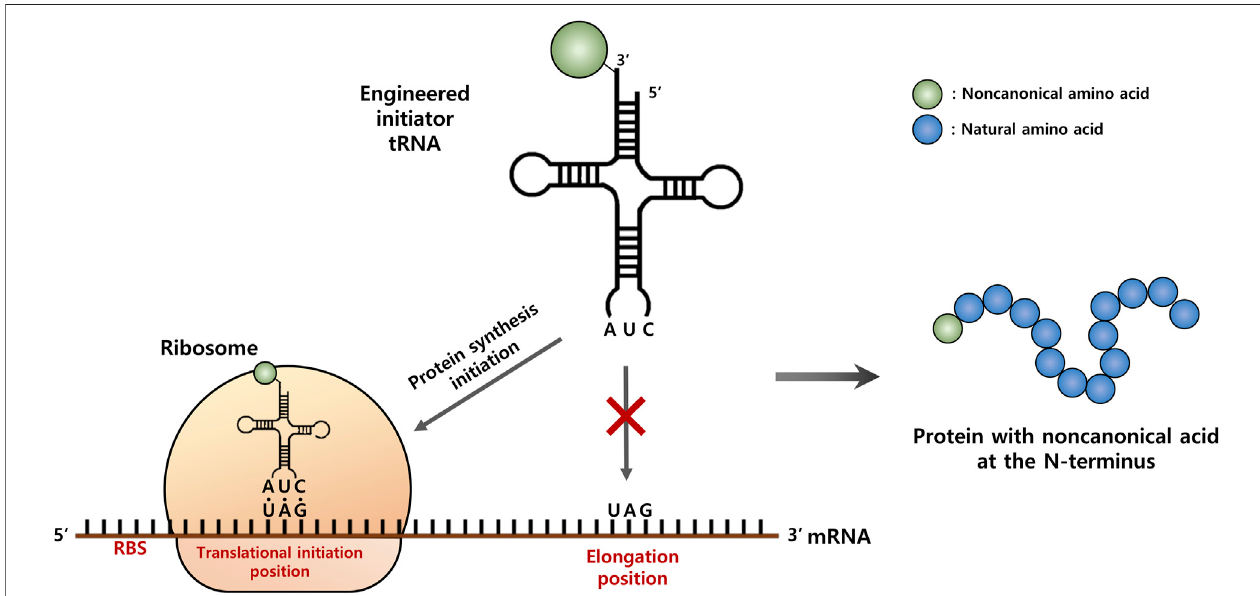
FIGURE 1 | Schematic representation of the strategy for site-speci fi c incorporation of a non-canonical amino acid (ncAA) into the start position of protein translation. An engineered initiator, tRNA CUA charged with a ncAA is active toward the protein translation initiation with the amber (TAG) codon, but inactive for the elongation process.